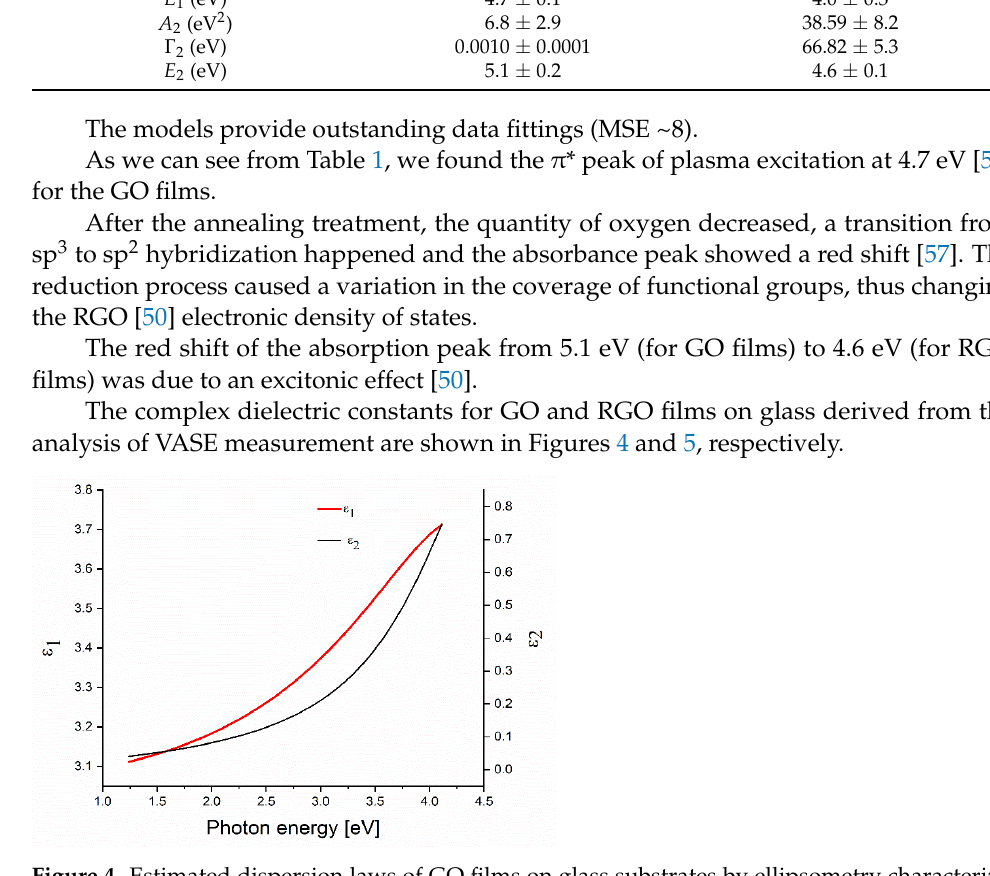
Figure 4. Estimated dispersion laws of GO films on glass substrates by ellipsometry characteriza- tion. The solid curves represent the real (red curve) and the imaginary (black curve) part of the dielectric constant.